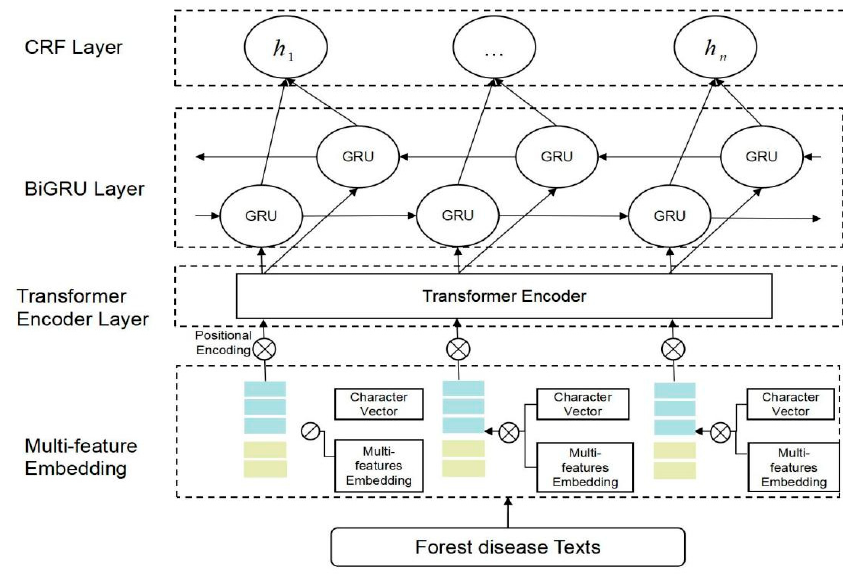
Figure 1. Named entity recognition method for forest disease